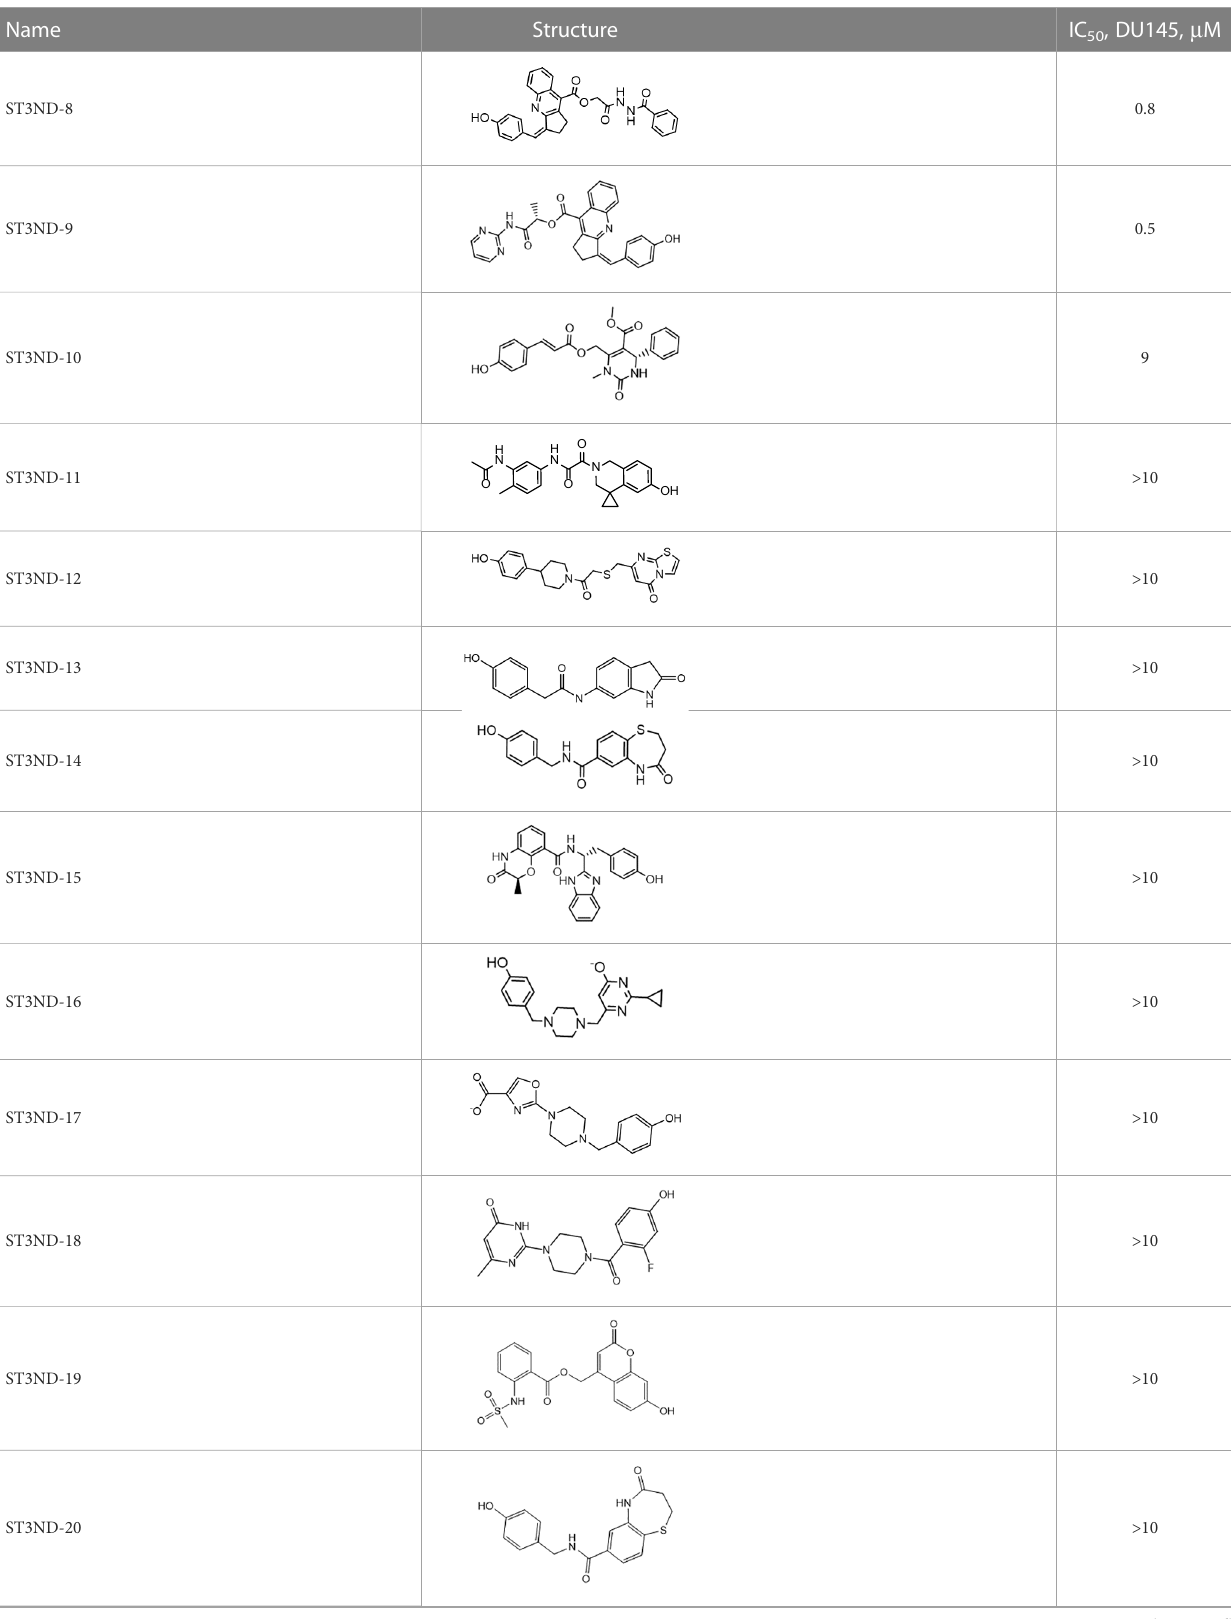
TABLE 2 Compounds selected for testing after docking of REAL and SAVI diversity sets and subset of subsets of whole REAL and SAVI databases identi fi ed using similarity